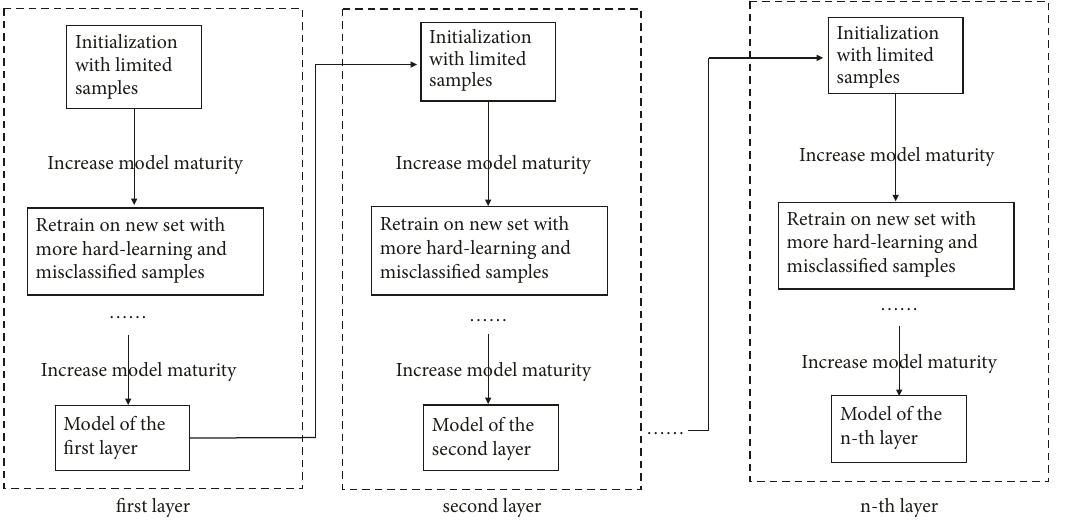
Figure 2: The network model of the proposed